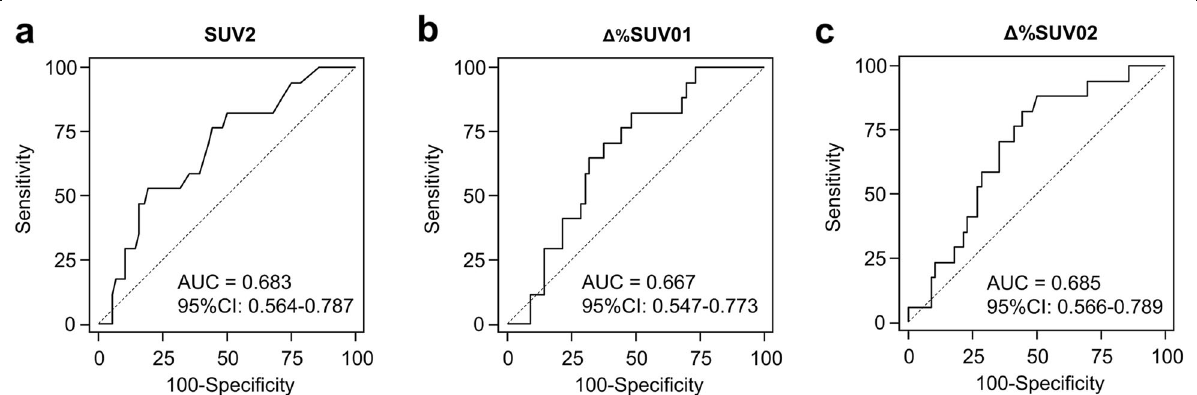
Fig. 1 ROC curves of SUV2, Δ %SUV01, and Δ %SUV02 using [ 18 F]FDG PET for predicting event-free survival of osteosarcoma. SUV2 is the SUV max of the primary tumor after completion of neoadjuvant chemotherapy ( a ). Δ %SUV01 is the percentage change in SUV max between baseline and interim of [ 18 F]FDG PET ( b ). Δ %SUV02 is the percentage change in SUV max between baseline and posttherapy of [ 18 F]FDG PET/CT ( c )